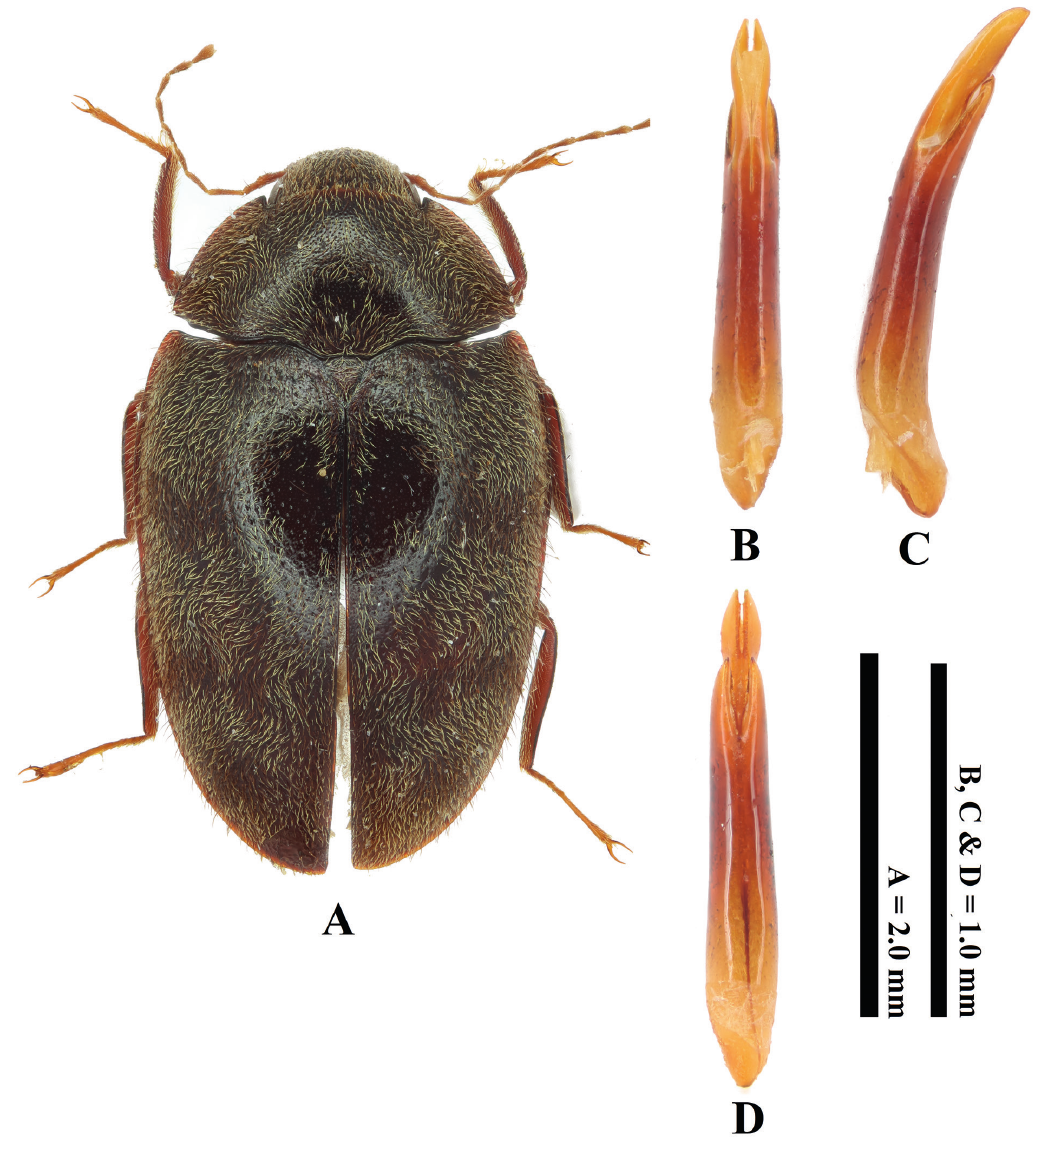
Fig. 3. Caccothryptus championi sp. nov., ♂, holotype (NHMUK011225382). A . Dorsal habitus. B . Genitalia, dorsal. C . Genitalia, lateral. D . Genitalia,